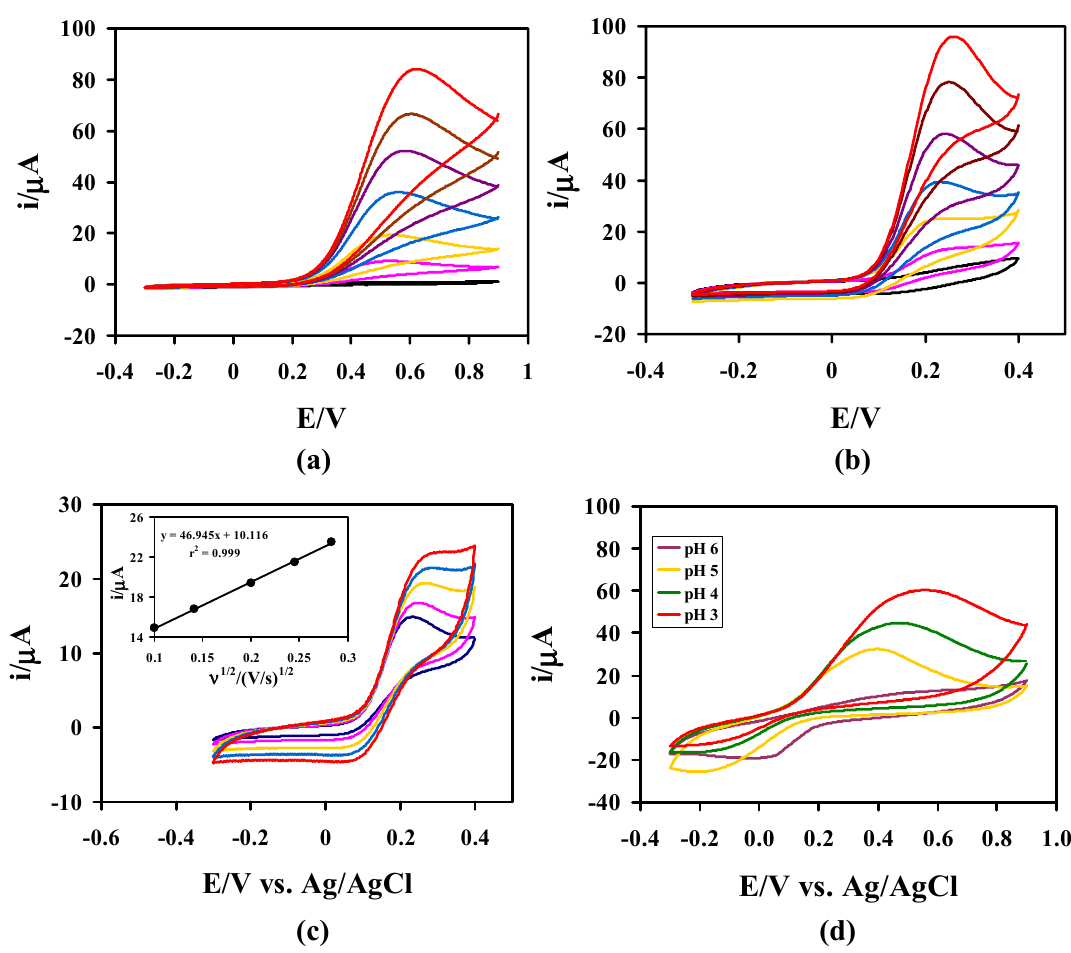
Figure 3. The CVs of AA at (a) the bare GCE and at (b) the poly(Ani- co - m -FcAni)/GCE in 0.1 M citrate buffer (pH 5.0) at scan rate of 50 mV s − 1 in the presence of AA at concentrations: 0.0, 1.0, 2.0, 4.0, 6.0, 8.0 and 10.0 mM ( vs. Ag/AgCl). (c) CVs with various potential scan rates in the presence of 2.0 mM AA in 0.1 M citrate buffer (pH 5.0) at the poly(Ani- co - m -FcAni)/GCE. Inset shows the relationship between the oxidation current and the square root of the scan rate with linear regression, and (d) CVs of 4.0 mM AA at the poly(Ani- co - m -FcAni)/GCE at different pH buffer